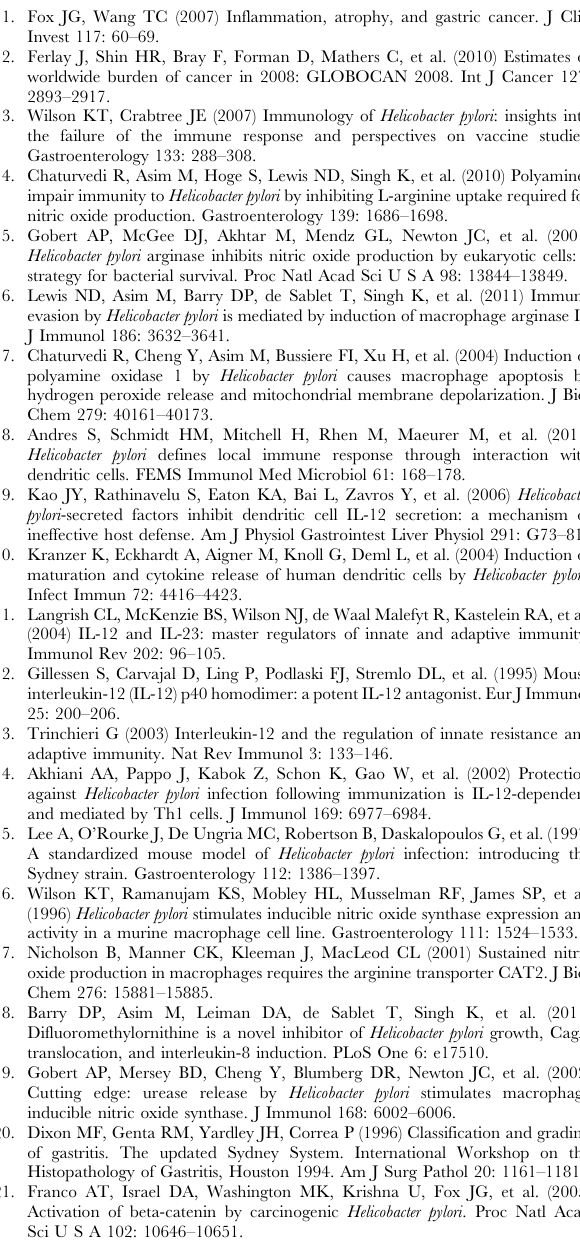
Figure S2 Lack of iNOS expression in dendritic cells in chronic H. pylori infection. (A) Pieces of glandular stomach tissue from mice 4 months post-inoculation and controls were sectioned, mounted, and stained for immunofluorescence. CD11c was detected with phycoerythrin-tagged antibody (red), iNOS was identified with FITC-tagged antibody (green), and nuclei were stained with DAPI (blue). There is no yellow cytoplasmic coloring in the merged images indicating an absence of colocalizing CD11c and iNOS within cells. Representative photomicrographs were captured at 200 6 . (B) High power images (600 6 ) of the same sections. (TIF)